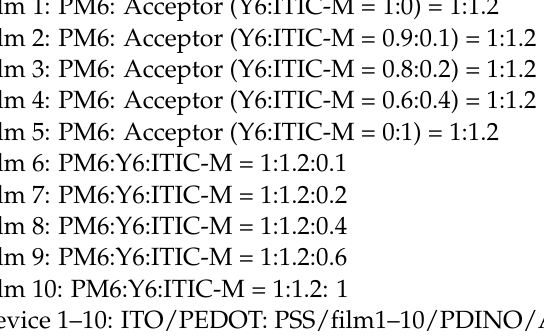
Figure 1. ( a ) The structure of solar cells device, ( b ) the energy level diagram and ( c ) the molecular structure of the polymer donor PM6 and the non-fullerene acceptor Y6 and ITIC-M. As the solutions for ternary devices, in one batch, the polymer donor to the acceptor ratio was kept constant as 1:1.2 and the ratio of Y6 to ITIC-M was changed. In another batch, the ratio of PM6 to Y6 was kept as 1:1.2, and the content of ITIC-M in the bulk- heterojunction (BHJ) was changed. The prepared active layer films and corresponding devices are as follows: